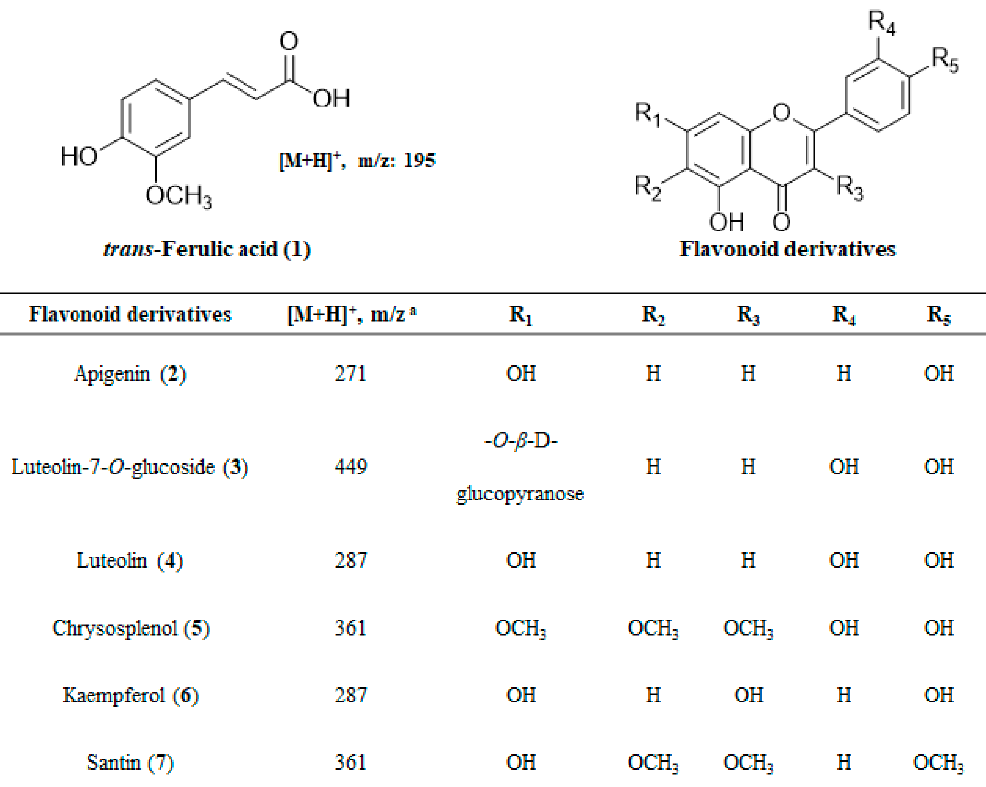
Figure 3. Chemical structures of compounds isolated from Tanacetum parthenium L. a The mass to charge ratio was obtained by Electron ionization-Mass (EI-MS) or Fast atom bombardment-Mass (FAB MS).